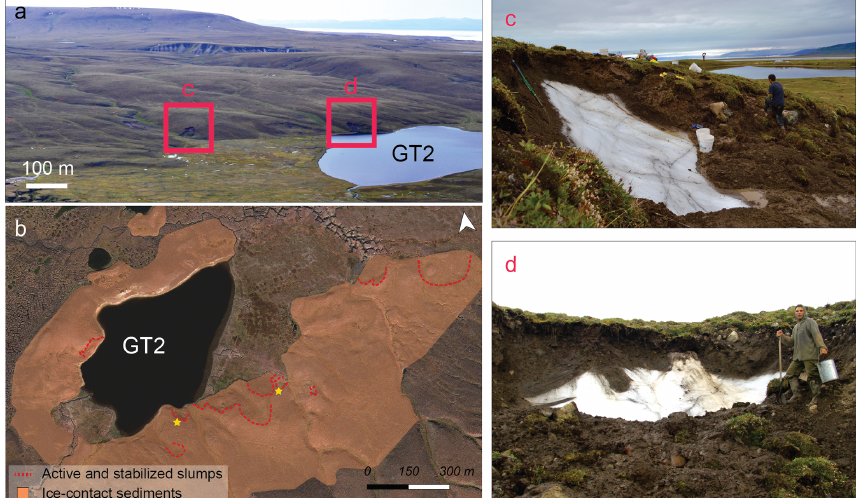
Figure 4. (a) Aerial view of two exposures of buried glacier ice located near glacial thermokarst lake GT2. (b) Map showing the distribution of active and stable thaw slumps near glacial thermokarst lake GT2 (background: GeoEye, 2010). (c) We interpreted the massive ground ice, exposed at the headwall of thaw slump, as buried glacier ice on the basis of cryostratigraphic, crystallographic and geochemical analyses (Coulombe et al., 2019). (d) This massive ice exposure was not studied in detail since the ice had been buried again under a thick cover of slump material. However, the ice displays a very similar appearance to the first exposure located 100m away (photo courtesy of Denis Sarrazin).